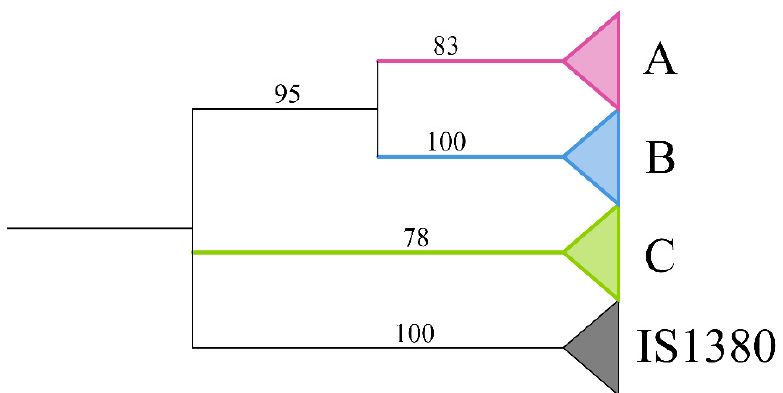
Figure 4. Phylogenetic tree of piggyBac ( PB ) elements in Apoidea identified in this study together with 24 reference sequences. The sequences of IS1380 were used as the outgroup. Red, blue, and green, respectively, represented three types of PB transposons (A–C). The complete evolutionary tree is in Figure S1.